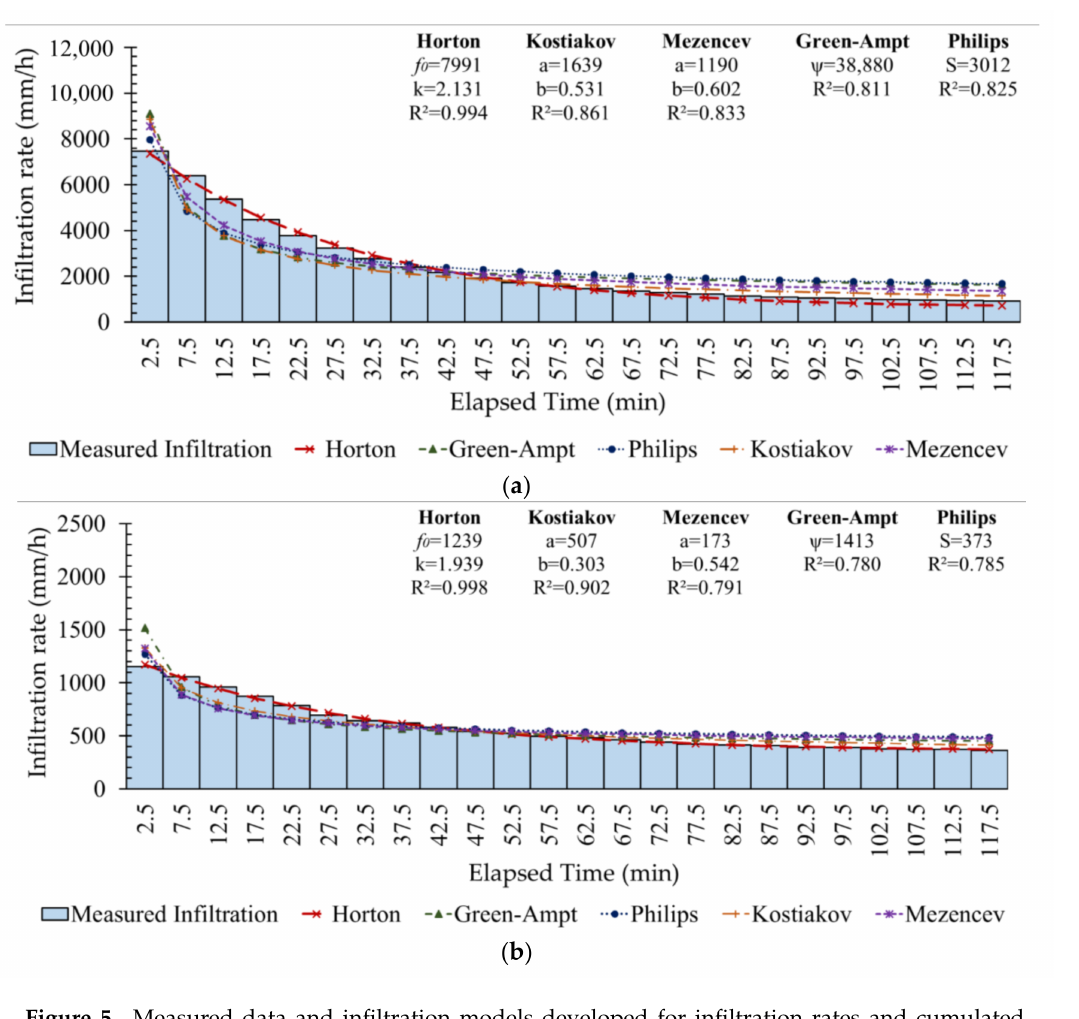
Figure 5. Measured data and infiltration models developed for infiltration rates and cumulated infiltration: ( a ) In newly built specimens, and ( b ) in clogged